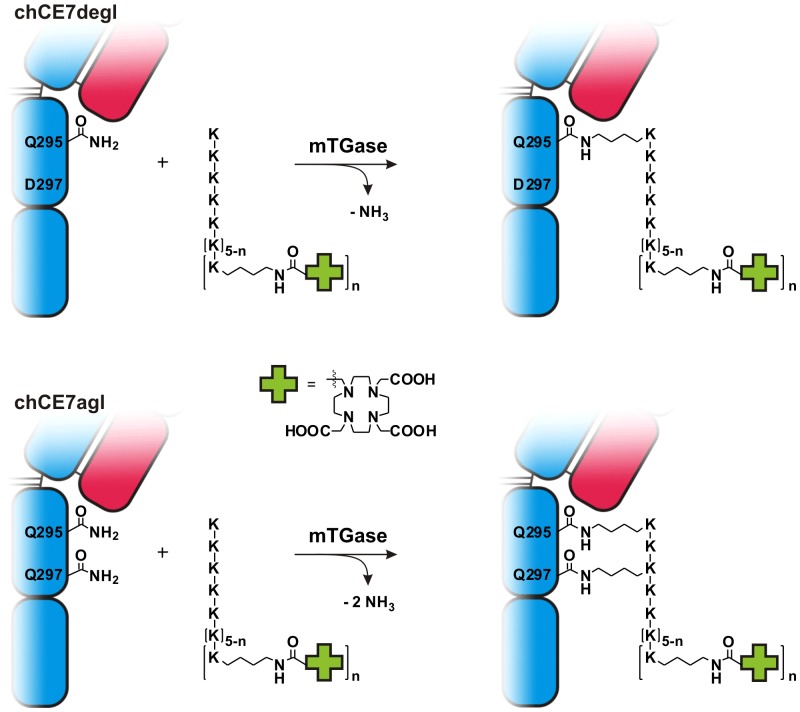
Enzymatic conjugation of (DOTA)n-decalysine to chCE7degl or chCE7agl, an aglycosylated variant of the antibody.Although there are two enzymatic recognition sites per heavy chain of chCE7agl (Gln295 and Gln297), only one molecule of (DOTA)n-decalysine (n = 1, 3, 5) was conjugated using transglutaminase. Interestingly, two isopeptide bonds were formed between one substrate and one heavy chain, as indicated by the loss of two ammonia molecules (bottom).